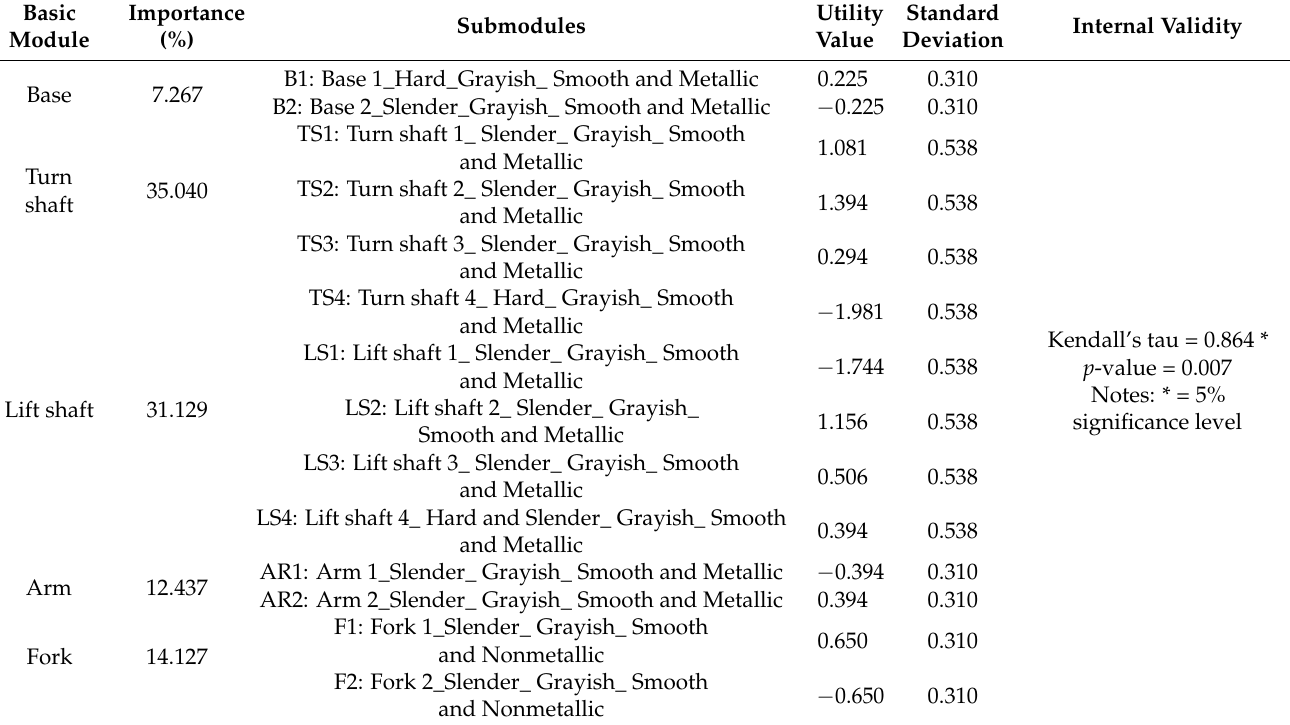
Table 6. Results of conjoint